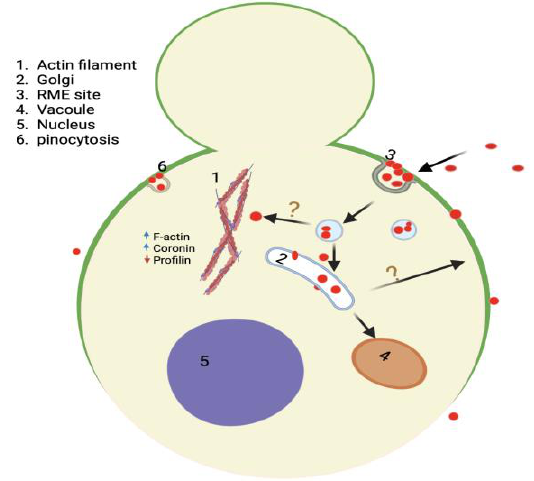
Figure 14 . Model summarizing the interaction and impact of QDs in yeast, including their mode of entry mainly by endocytosis, and their trafficking to the Golgi. The model also shows multiple impacts QDs have on yeast cells, such as loss of polarized GFP-Snc1 membrane distribution and alteration of actin dynamic regulatory protein to support actin polymerization and bundling. Created with BioRender.com .